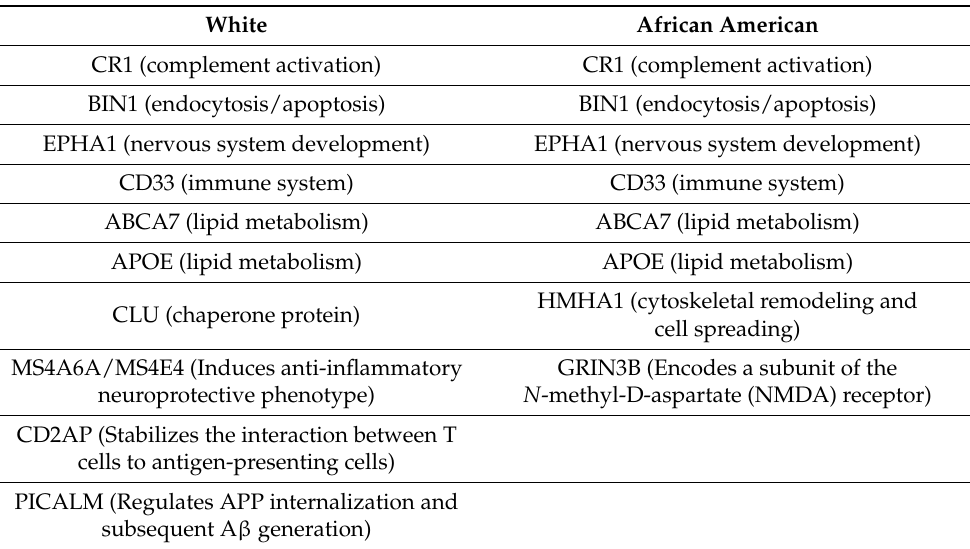
Table 3. Known genetic loci associated with AD in whites and African Americans